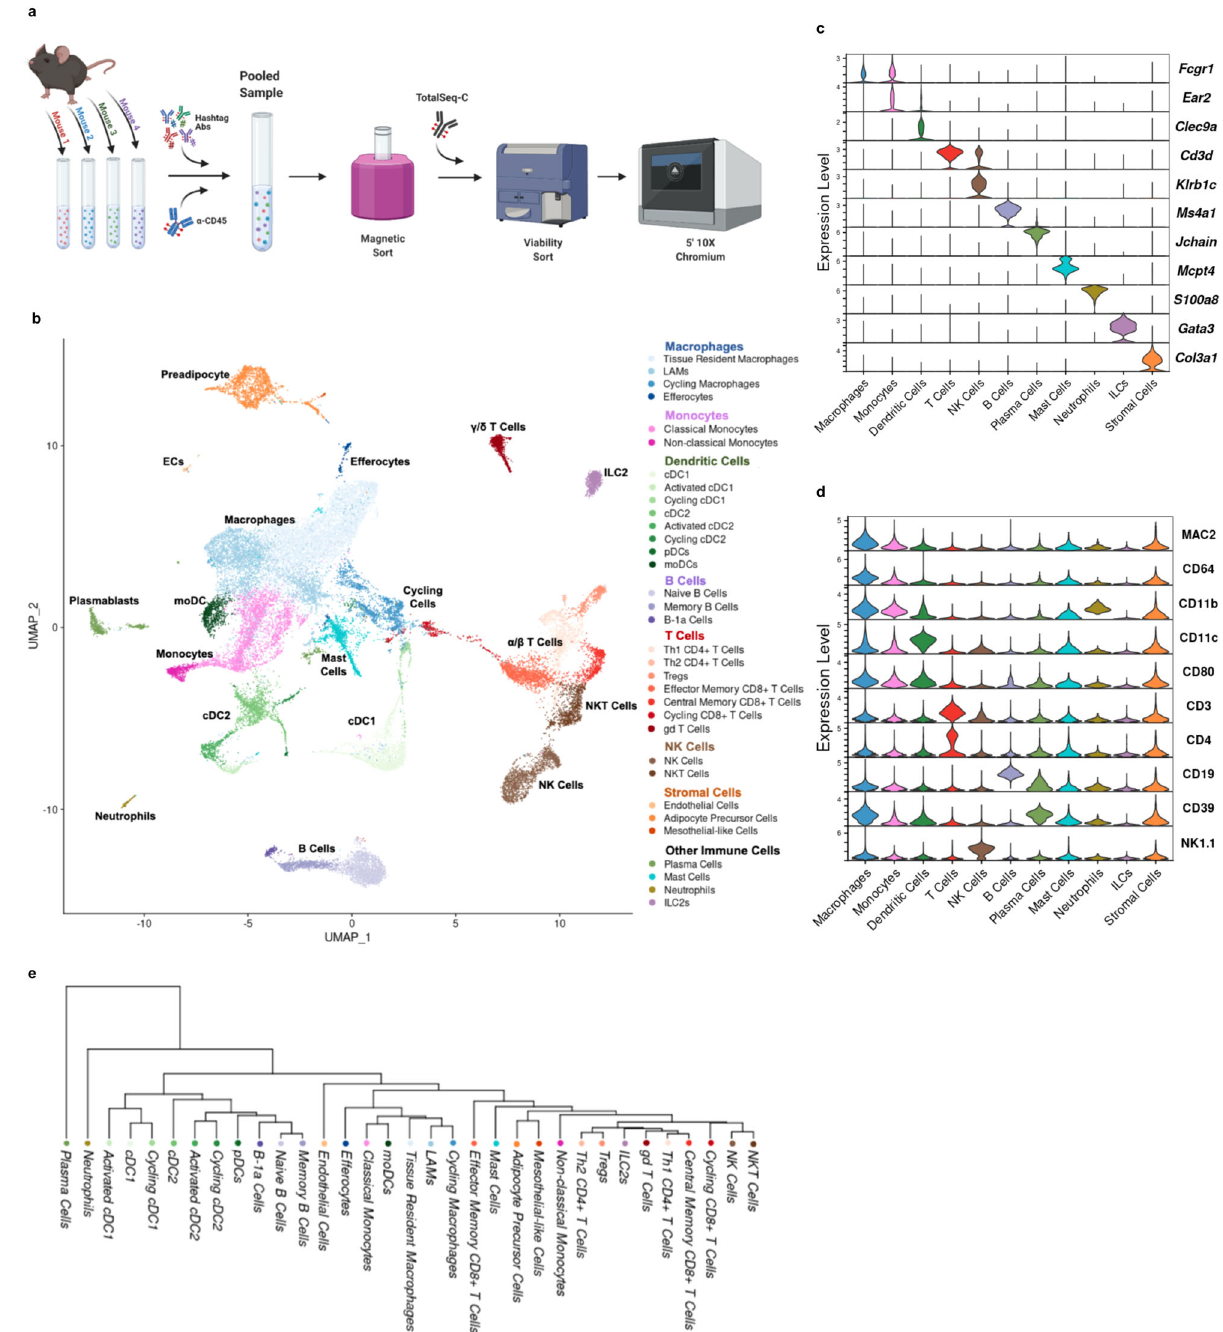
Fig. 2 Adipose tissue immune cell populations observed by CITE-seq. Schematic of CITE-seq approach using hashtag antibodies (Abs) and Total-SeqC antibodies. b Unbiased clustering of 33,322 single cells labeled broadly by cell type category and colored by high-resolution cell type identities via Uniform Manifold Approximation and Projection (UMAP). Populations include lipid-associated macrophages (LAMs), conventional dendritic cells (cDCs), plasmacytoid DCs (pDCs), monocyte-derived DCs (moDCs), T helper (Th) cells, T regulatory cells (Tregs), gamma-delta (gd) T cells, natural killer (NK) cells, and type 2 innate-like lymphoid cells (ILC2s). Selected markers of speci fi c cell subsets based on c gene expression and d surface protein. e Phylogenetic tree of high-resolution cell type identities. Figure 2a was created with